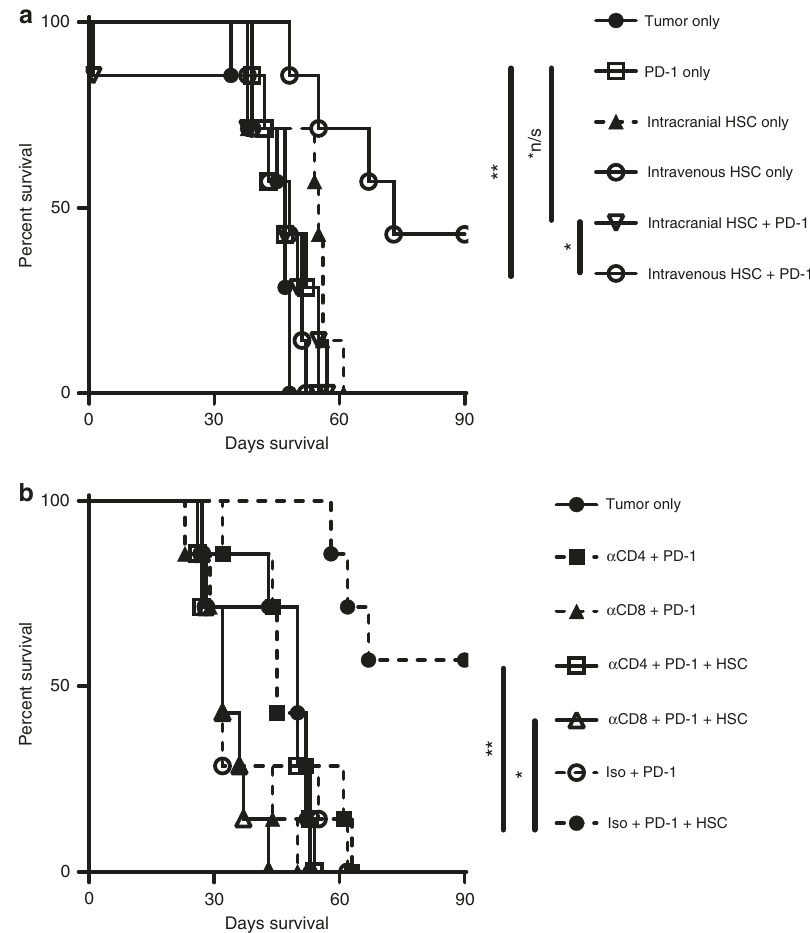
Fig. 2 Ef fi cacy of HSC + PD-1 is dependent on both CD4 and CD8 lymphocytes. a KR158B glioma tumor-bearing mice received no treatment, PD-1 only, intracranial HSCs, intravenous HSCs, intracranial HSC + PD-1, or intravenous HSCs + PD-1 and observed for survival (* p = 0.0039, ** p = 0.0056, *n/s p = 0.9491, n = 7 mice/group; Gehan – Breslow – Wilcoxon statistical test). b Glioma-bearing mice were depleted of CD4 + or CD8 + cells, then received either PD-1 or HSC + PD-1. Isotype + HSC + PD-1 served as the positive control (* p = 0.0001, ** p = 0.0002, n = 7 mice/group; Gehan – Breslow – Wilcoxon statistical test). All error bars represent